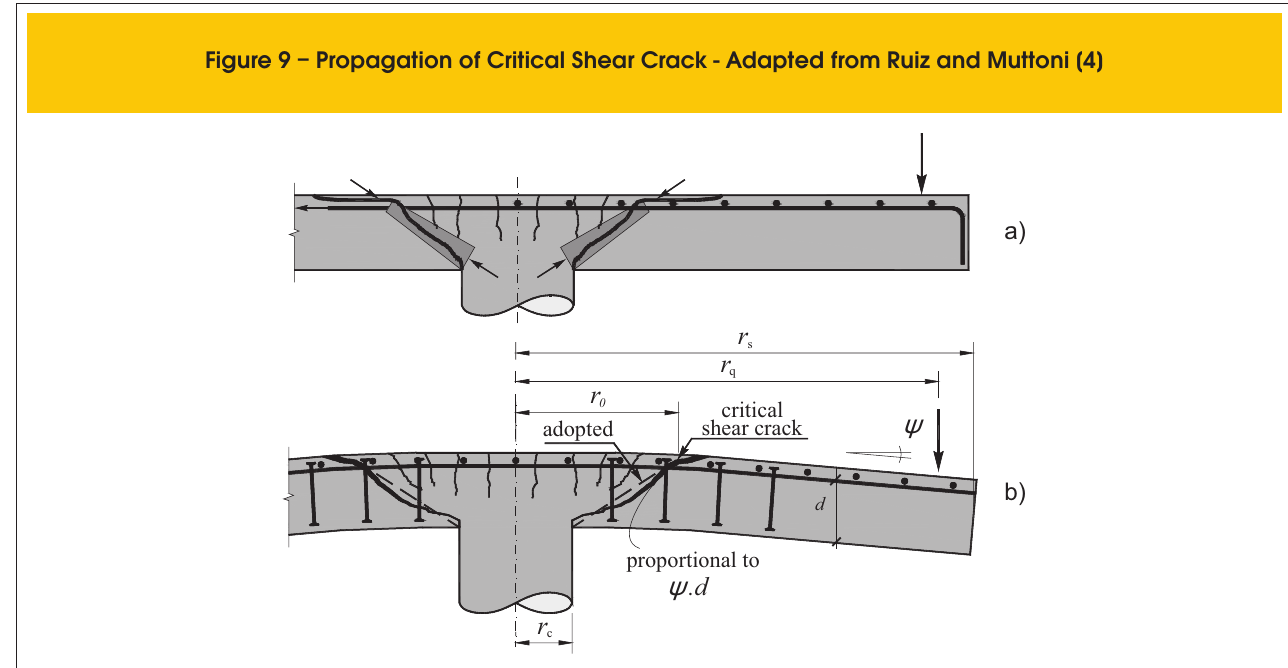
Figure 9 – Propagation of Critical Shear Crack - Adapted from Ruiz and Muttoni [4]